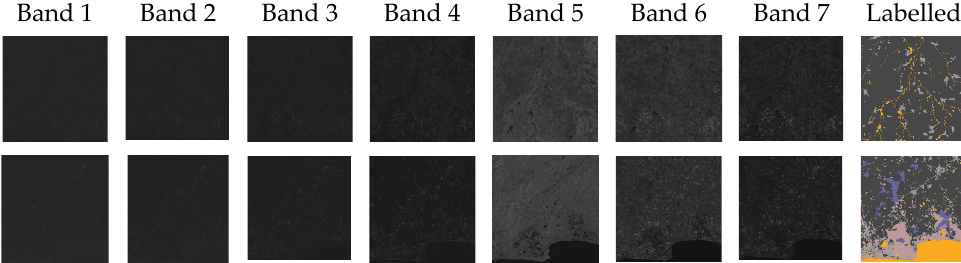
Figure 2. Sample sets of land use dataset showing the different spectral reflectance from Band 1 to Band 7 and labelled imagery. Band 7 and labelled